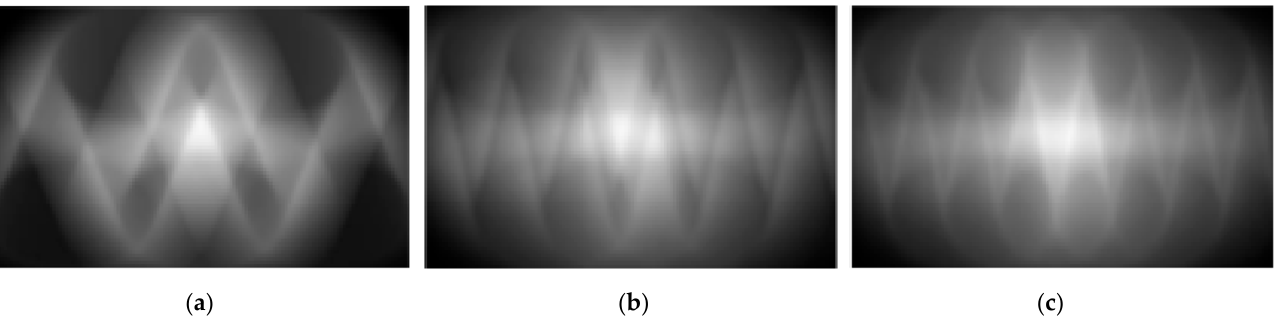
Figure 11. Abrasion images from polishing simulation, for three transverse velocities V T : ( a ) 40 mm/s; ( b ) 90 mm/s; ( c ) 200 mm/s, with x = r /8. ( b ) 90 mm/s; ( c ) 200 mm/s, with x = r /8.